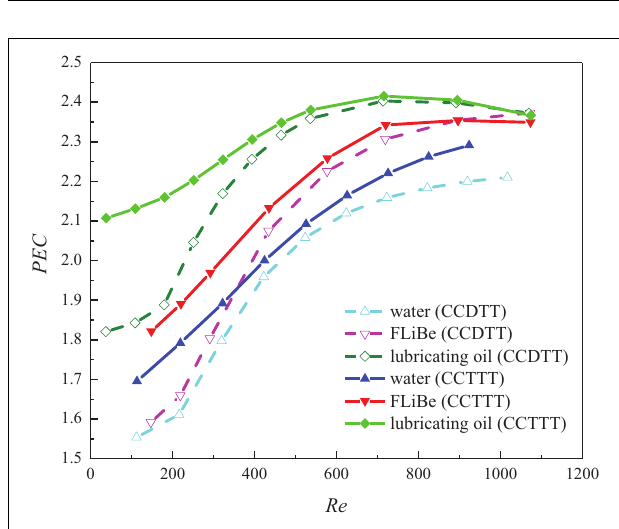
FIGURE 12 | Variation of Nusselt number ratio with the Reynolds number for different fluids in the tube fitted with CCDTT and CCTTT ( y = 3).